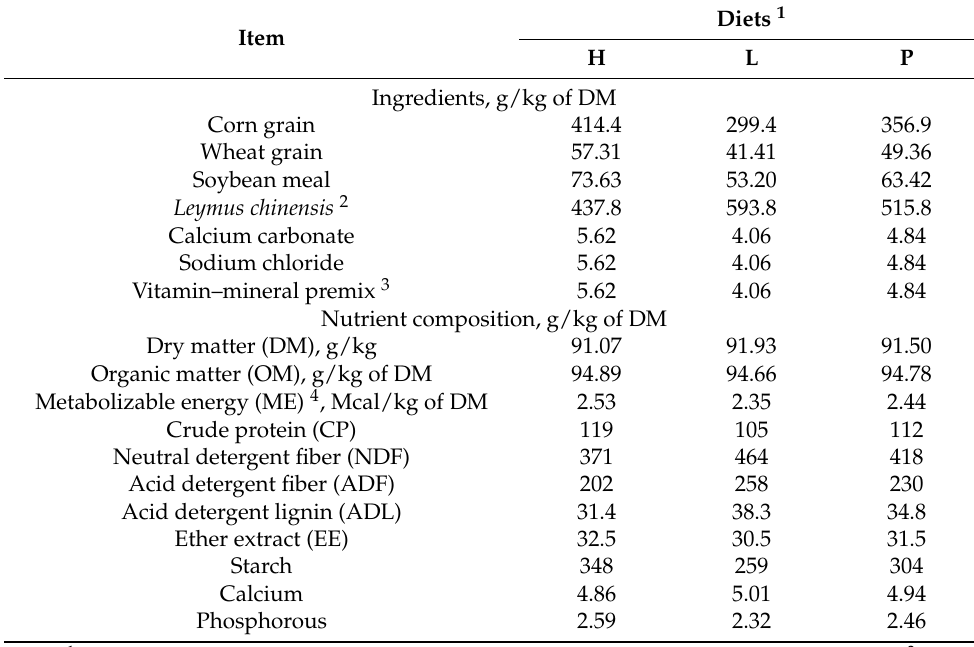
Table 1. Ingredients and nutrient composition of the experimental and pre-experimental diets.